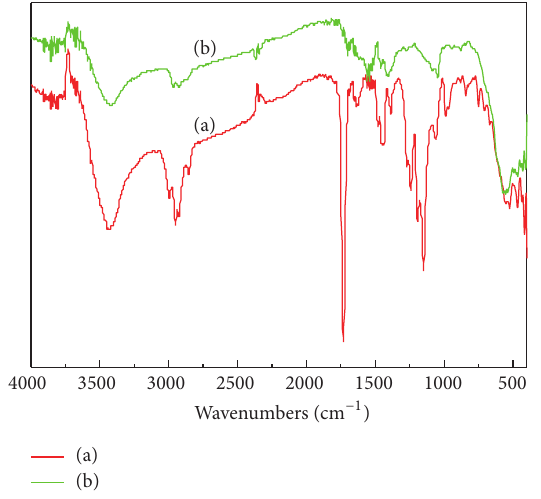
Figure 2: IR spectrum of (a) Fe(OH) 3 @PMMA composite micro- spheres and (b) magnetic